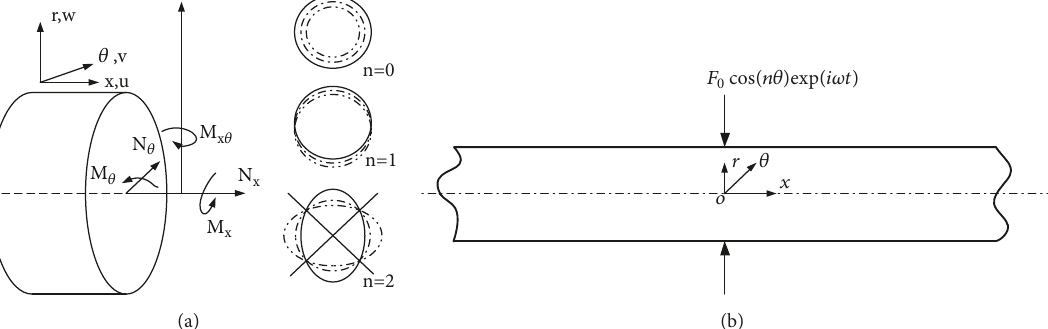
Figure 1: (a) Coordinate system and circumferential modal shape. (b) Harmonic line force F applied on thin laminated composite cylindrical